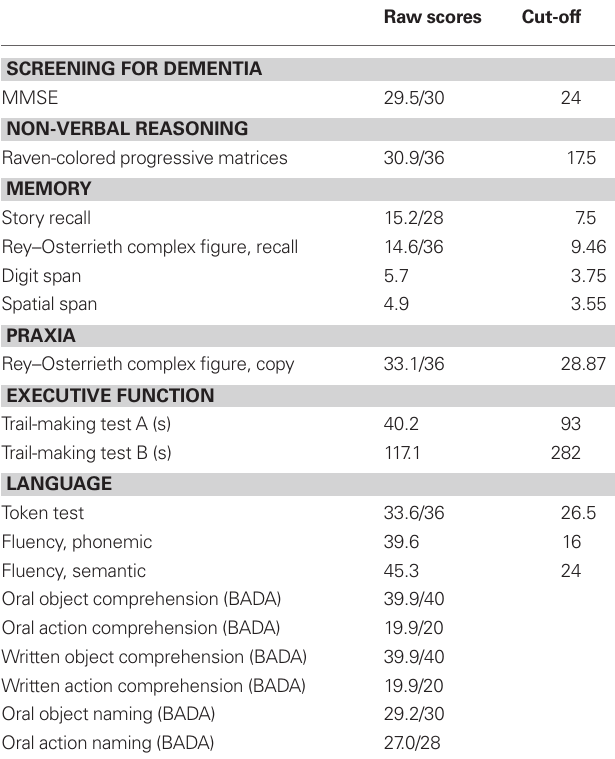
Table 1 | Neuropsychological data of the older adults who participated in Experiment 2.